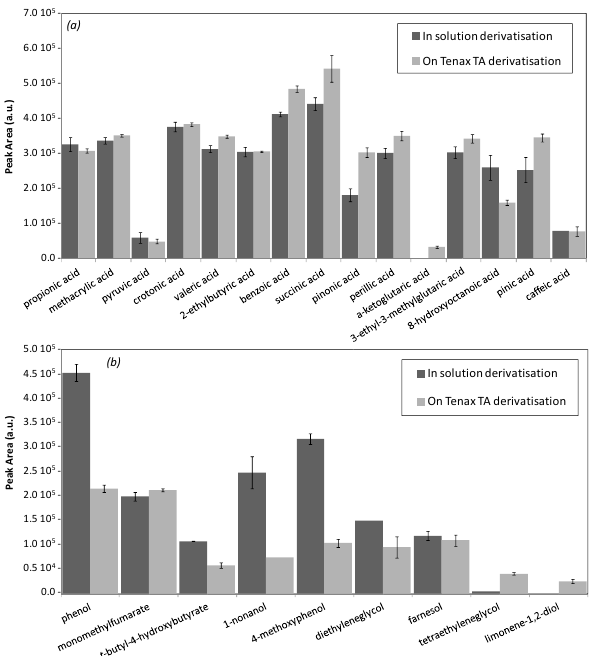
Fig. 10. Humidity influence on on-Tenax TA carboxyl/hydroxyl compounds MTBSTFA derivatisation: (a) carboxylic acids derivatisation results, (b) hydroxyl compounds derivatisation results. “Peak Area” refers to FID chromatogram, in area units. Error bars represent ± one standard deviation determined from three replicates.